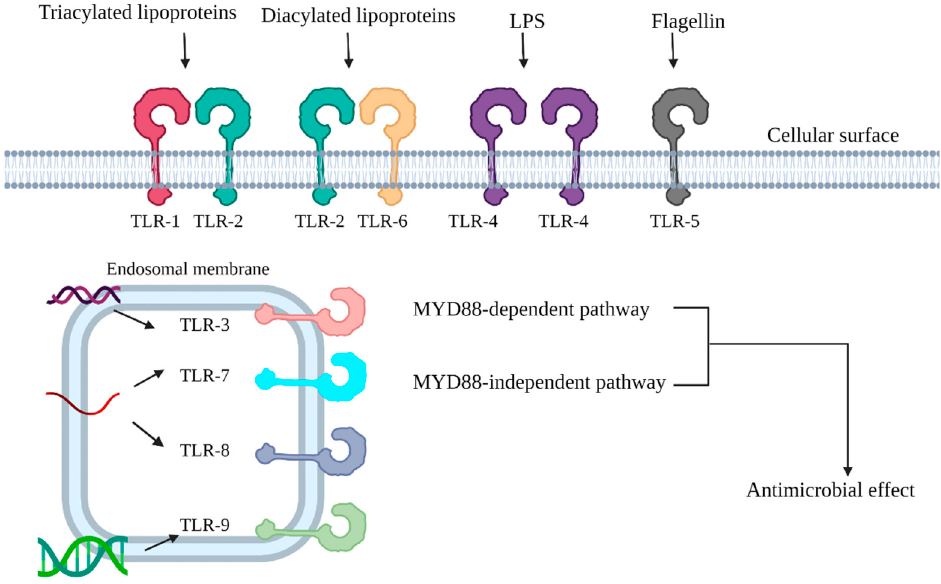
Figure 1. Each Toll-like receptor has its own function. The TLR1/2 complex recognizes the triacylated lipoprotein commonly found in Gram-negative bacteria, and the TLR2/6 complex recognizes the diacylated lipoprotein synthesized by Gram-positive bacteria [35–37]. LPS serves as a specific ligand for TLR4, and flagellin can bind to TLR5 [38]. With regard to TLRs located on the endosomal membrane, TLR3 recognizes dsDNA [39], and both TLR7 and TLR8 can recognize ssRNA [40]. TLR9 can bind to CpG-containing DNA [41]. Activated TLRs then trigger a downstream cascade and contribute to antimicrobial effects.